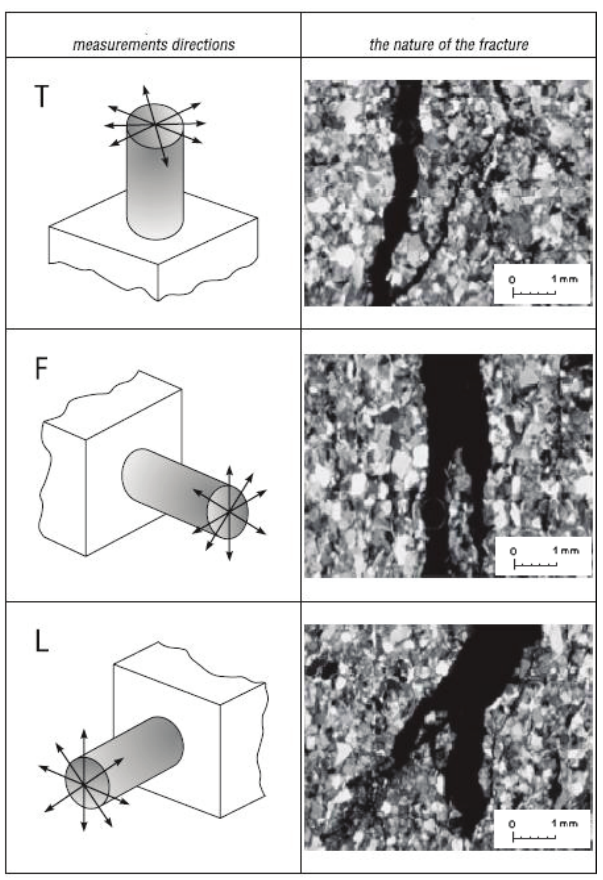
Fig. 6. Differences in the course and geometric properties of the resulting fracture based on orientation of the structural features